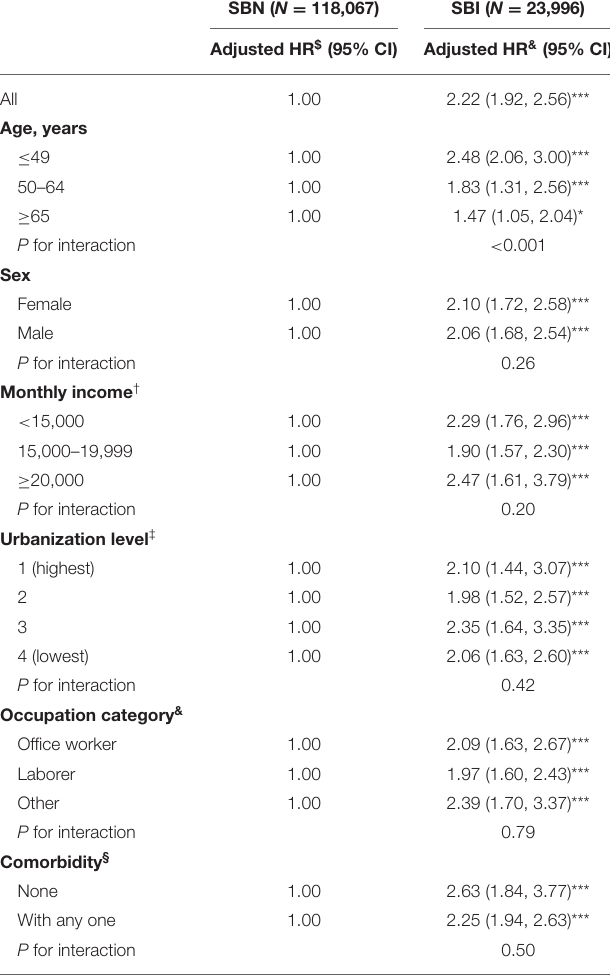
TABLE 3 | Comparison of incidence and hazard ratio for suicide attempt stratified by age, sex, and comorbidities between patients with SDB with and without head trauma.